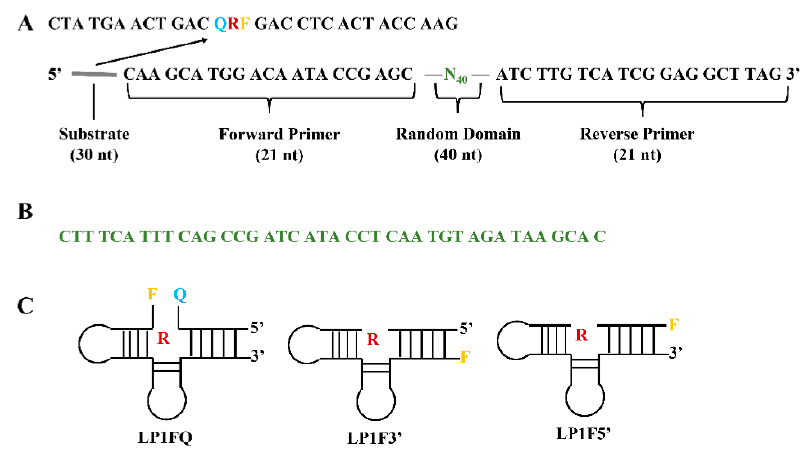
Figure 5. ( A ). The DNA general construct in the library for selection of DNAzyme specific to Legionella pneumphila. ( B ) The random domain of selective Legionella pneumphila DNAzyme. ( C ) Representative construction of selected DNAzyme. R: Adenosine ribonucleotide, F: Fluorescein tail molecules, Q: quencher tail molecules (DABCYL). Redrawn based on Ref. [75] .